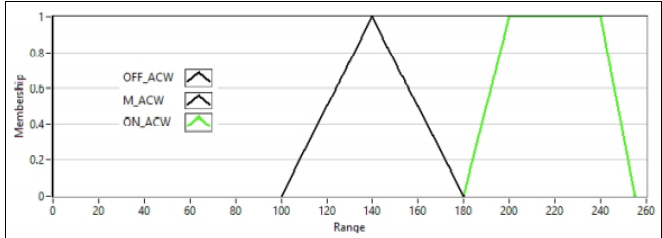
Figure 13: Graph of member functions of the Polar motion motor.